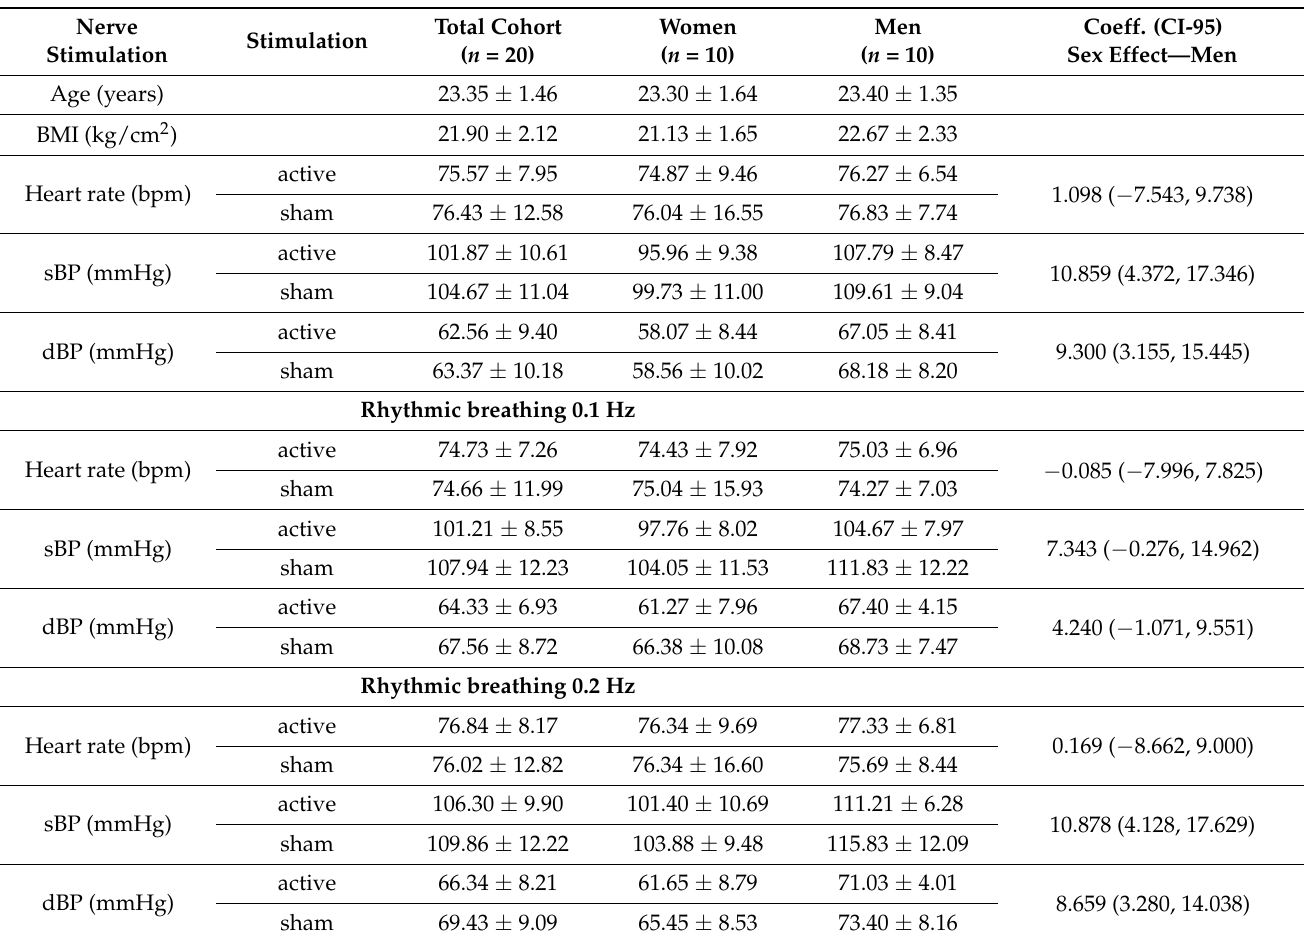
Table 1. Baseline characteristics of participants during nerve stimulation and rhythmic breathing before vagus nerve stimulation. Displayed are means ± SD. Baseline value differences between sexes were tested by using Mann–Whitney U test (age and BMI) and linear mixed models (heart rate, systolic blood pressure (sBP) and diastolic blood pressure (dBP)). Estimated coefficients (Coeff.), representing the effect of being male, and their respective 95% confidence interval (CI) are depicted in the last